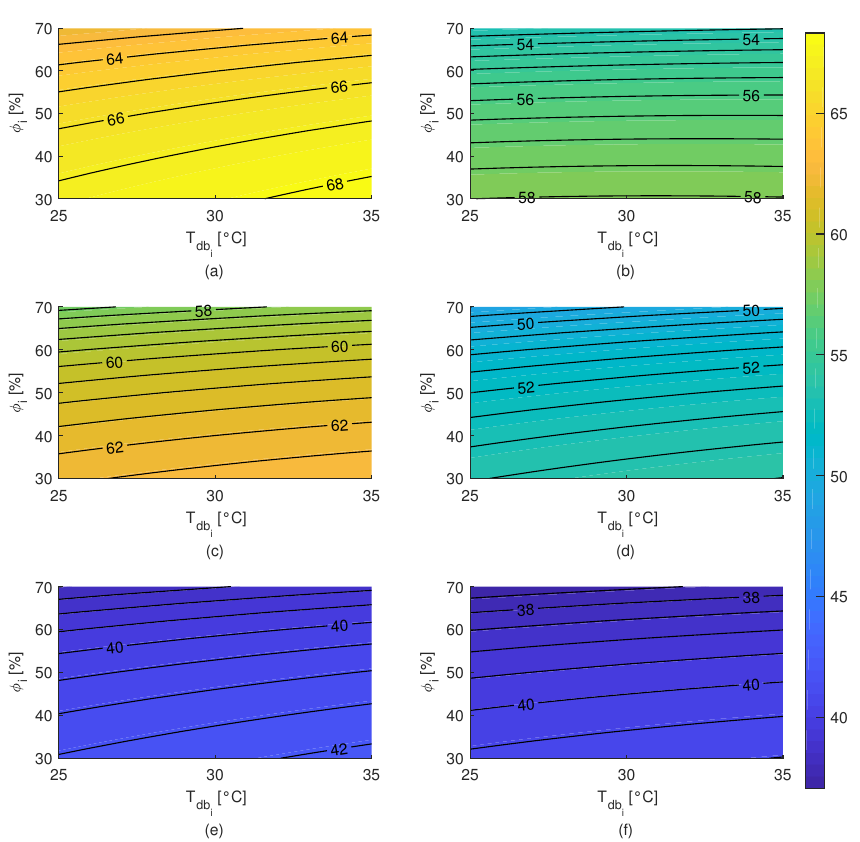
Figure A4. Pad cooling efficiency as a function of dry-bulb temperature of inlet air ( T db humidity ( φ i ) for the pad materials studied. ( a ) Cellulose. ( b ) Small coconut shell (7.9–12.7 mm). ( c ) Big coconut shell (12.7–19.0 mm). ( d ) Burnt-clay bricks (12.7–19.0 mm). ( e ) Small pumice stones (34.9–45.0 mm). ( f ) Big pumice stones (45.0–55.5